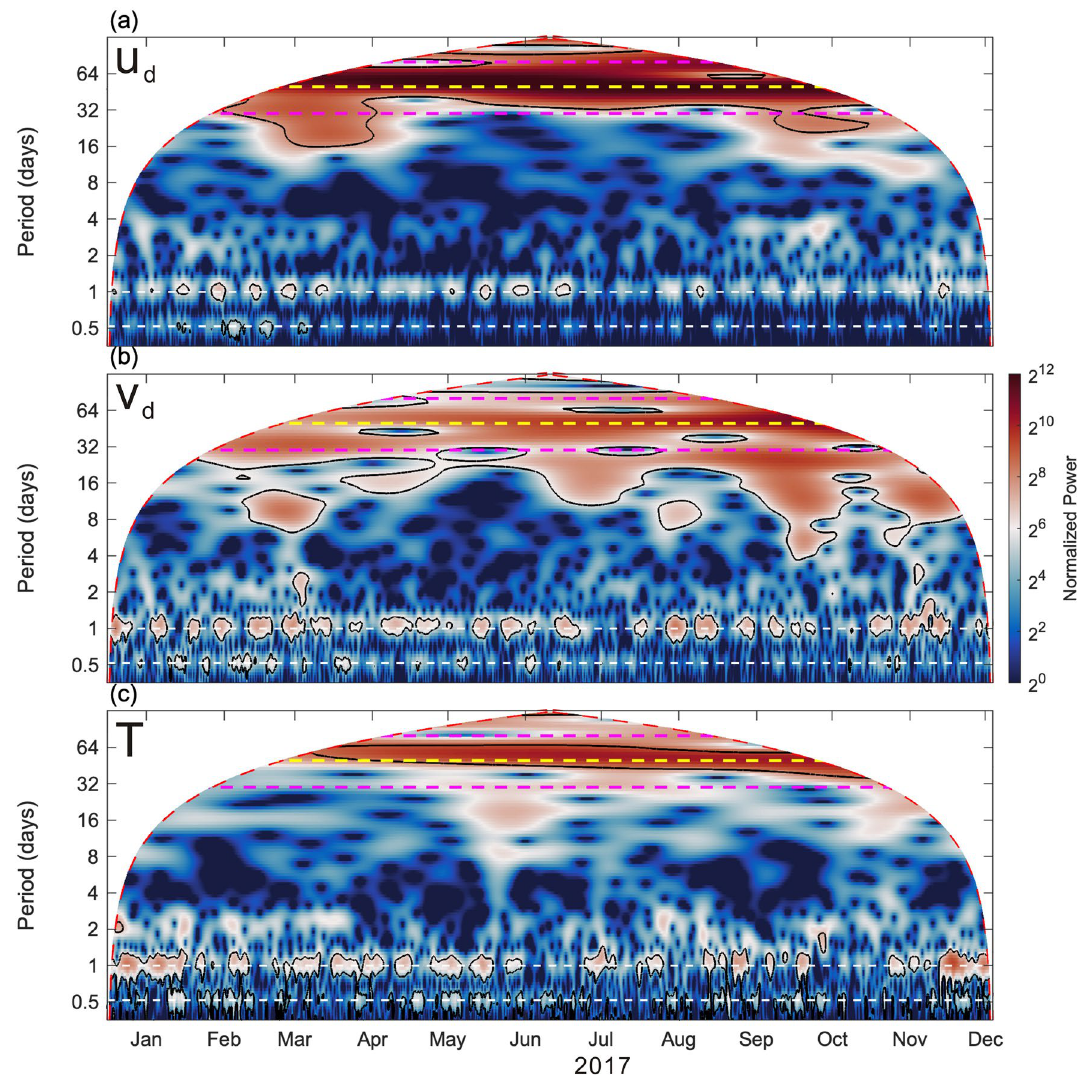
Figure 2. Wavelet power spectra of velocity and temperature. Wavelet spectra of depth-averaged velocity ( a ) u d , ( b ) v d , and ( c ) temperature obtained using a Morlet wavelet normalized with the corresponding variance. Black contours enclose the regions with a confidence level greater than 95%, red dashed lines indicate the cone of influence, white dashed lines represent the periods of diurnal K 1 and semidiurnal M 2 tides. Magenta lines indicate periods of 30- and 80-day, and the yellow dashed line in each panel indicates period